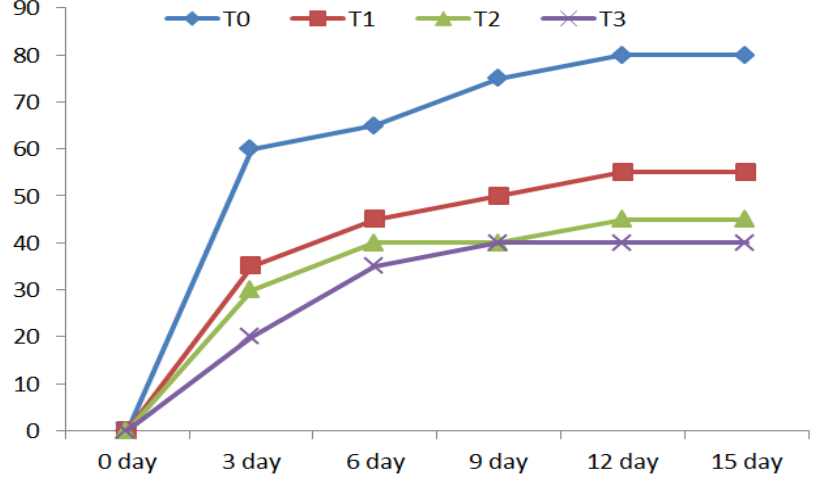
Figure 2. Cumulative mortality (%) of Red Tilapia ( Oreochromis sp . ) at days post-challenge.